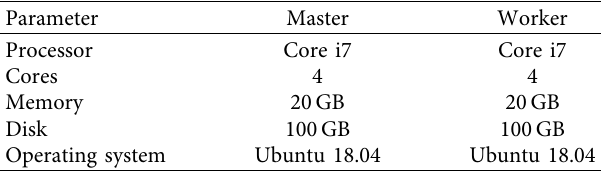
Table 1: Cluster nodes